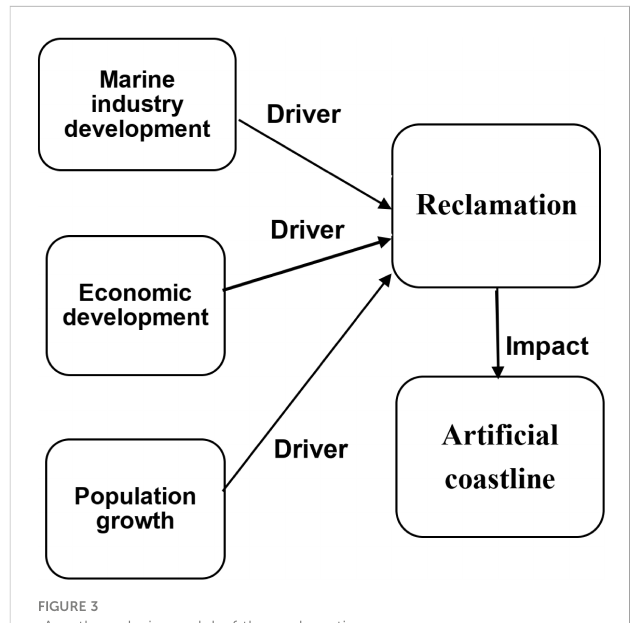
FIGURE 3 A path analysis model of the